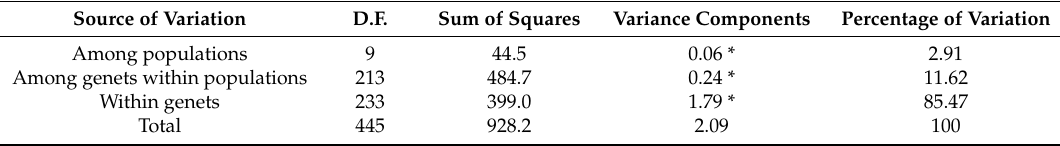
Table 3. Pairwise F ST values between 10 populations of matsutake